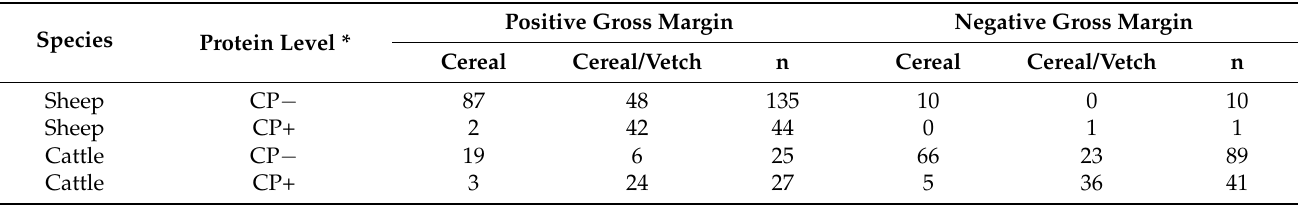
Table 4. Predicted number of crops (from a total of n = 193 crops) with positive and negative gross margins for each crop type and protein level for sheep and